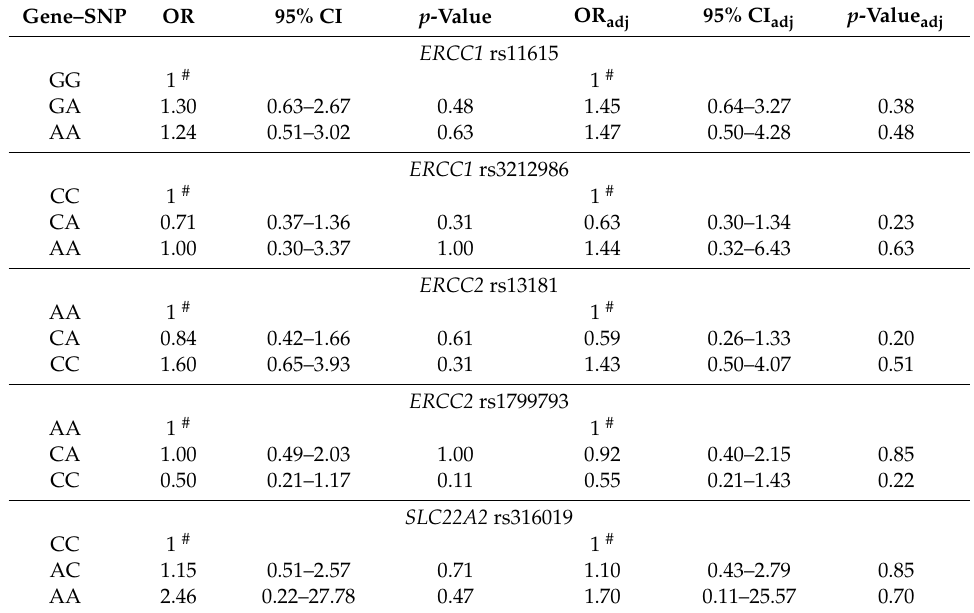
Table 5. Strength of genotypic association between genetic polymorphisms and cisplatin nephrotoxicity in adjusted-AKI outcome (N = 163).